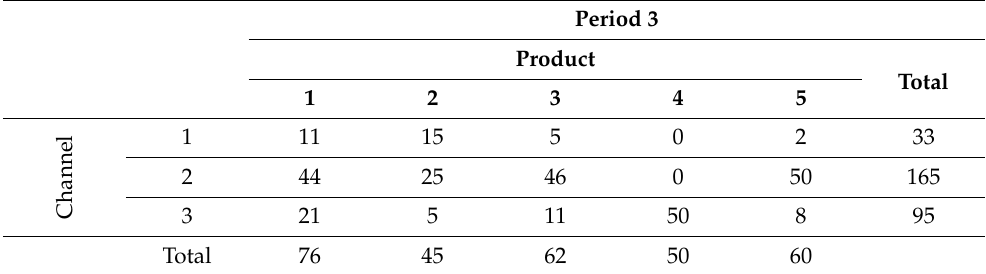
Table 5. Sales forecasting. Number of units of each product type for each channel during period 3.